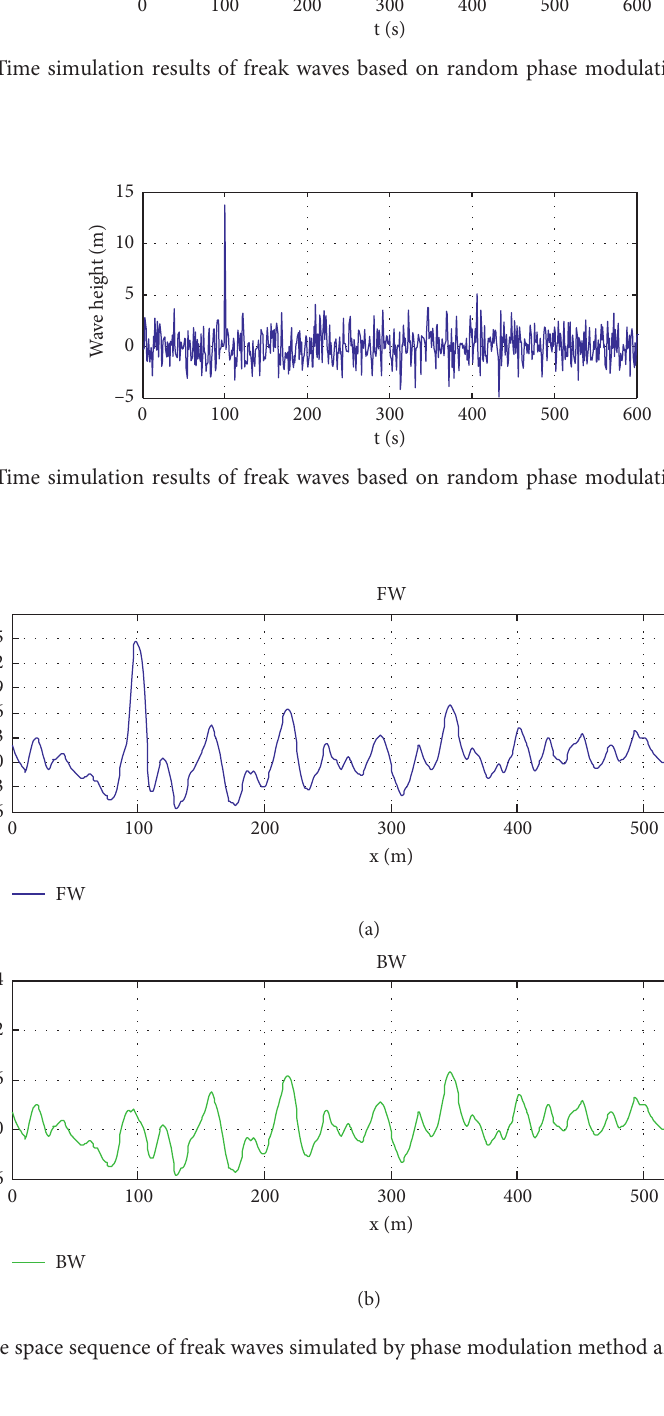
Figure 4: Time simulation results of freak waves based on random phase modulation when t